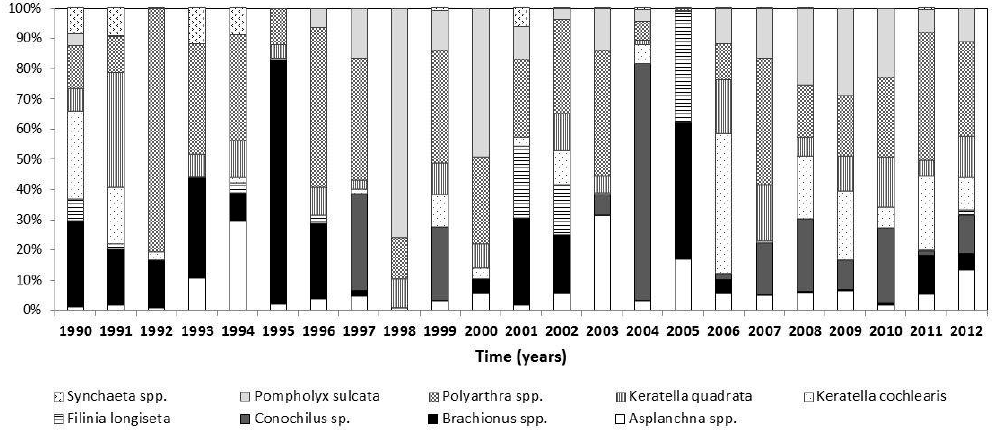
Figure 4. Relative abundance of rotifers for the period 1990–2012 in Lake Søbygaard. Averages for the spring–summer period are used for calculation of proportions. Only species accounting for more than 3% of total abundance are shown.